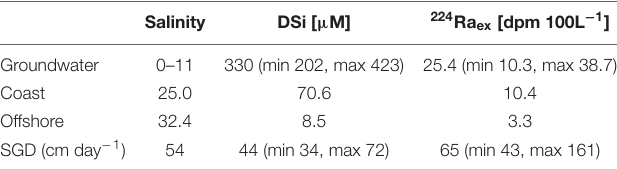
TABLE 2 | SGD calculations in southern Java based on 224 Ra ex , salinity and DSi mass